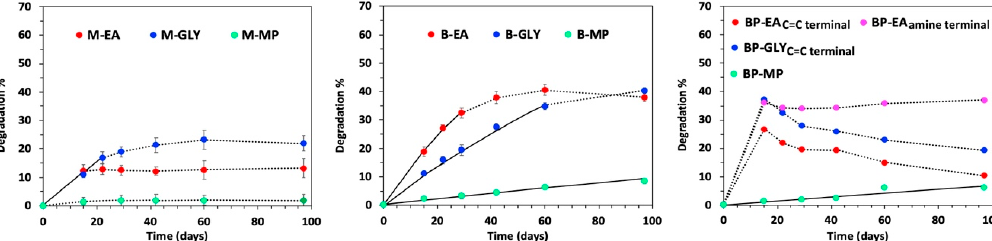
Figure 4. Degradation kinetics of PAAs at pH 7.0 and 25 °C. Concentration of the repeat unit 43.6 μ M. Each panel shows the degradation curves relative to polymers obtained from the same bisacrylamide. The solid circles, with the related error bars, represent the experimental data determined as the averages of the values obtained considering different terminal- and internal repeat unit reference peaks (see also the captions to Figures 2 and S12–S19). The continuous lines are the fitting curves calculated by using the first order kinetic constants of Table 5. The dotted lines (BP-EA and BP-GLY) refer to trendlines not following first order kinetics.